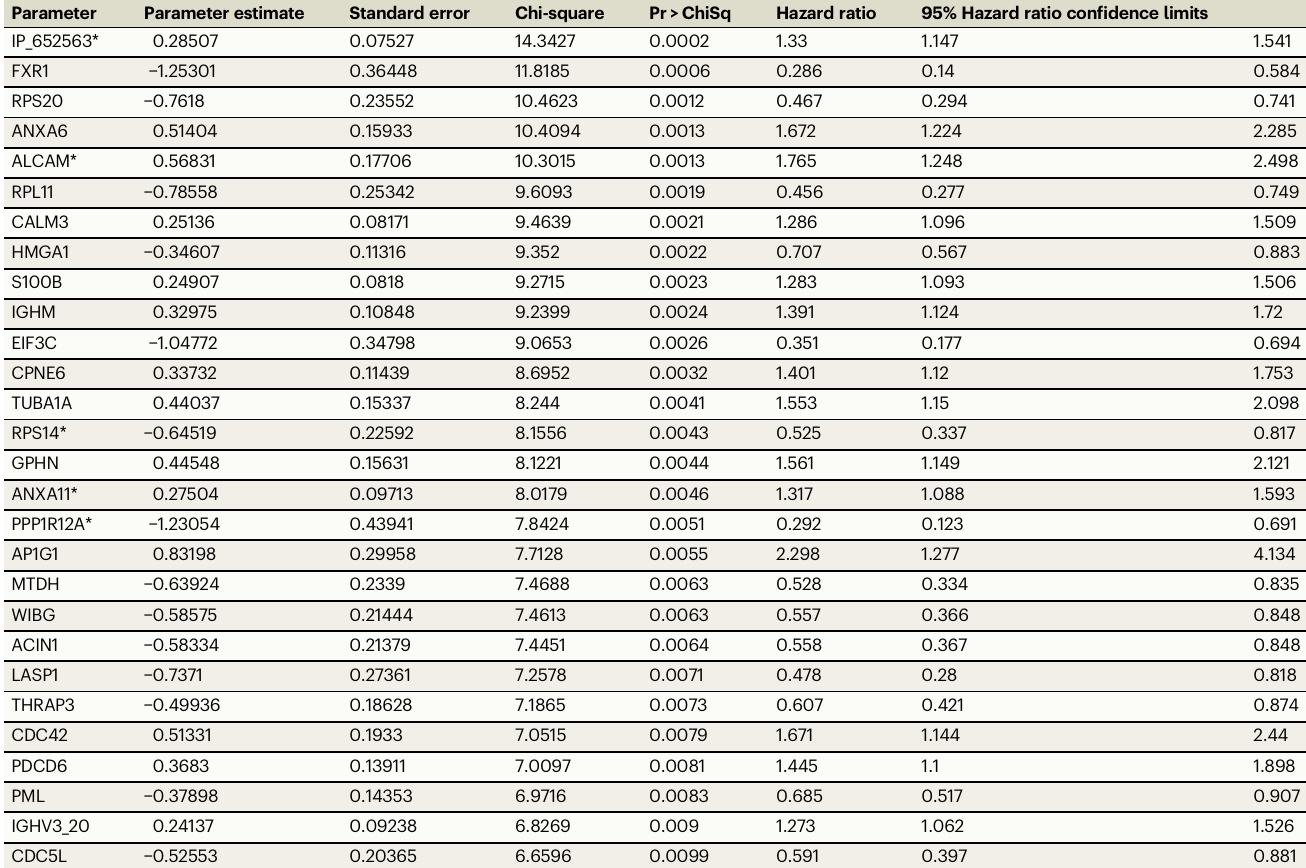
Table 4 | Proteins associated with survival after Cox model P < 0.01